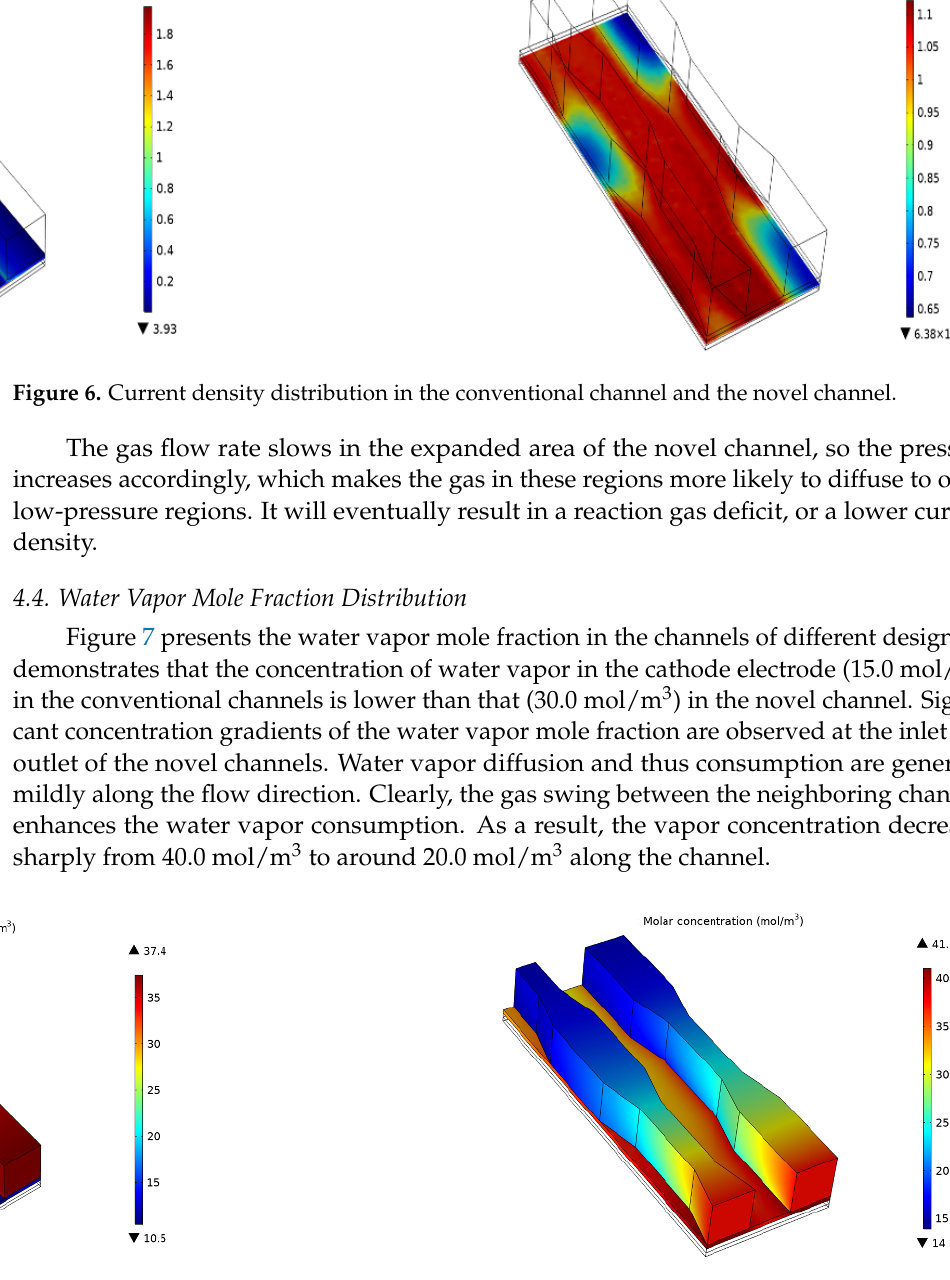
Figure 7. Water vapor mole fraction distribution in conventional channel and novel channel.